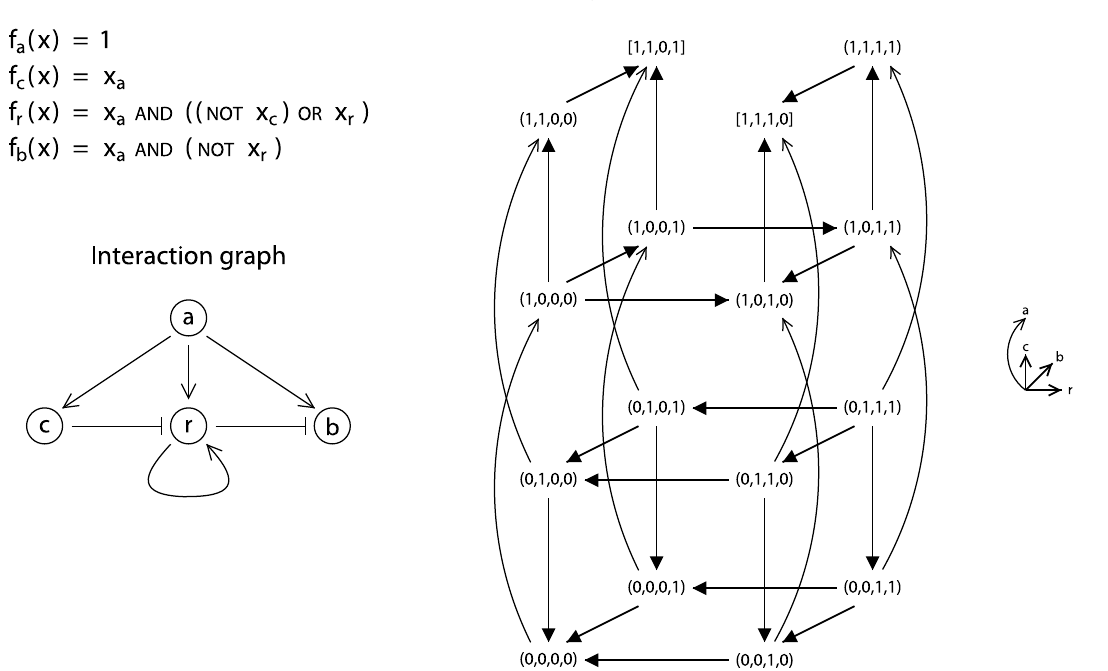
Figure 3. A minimal consistent Boolean network with 4 components. The asynchronous state graph is represented in a 4D-grid, with a in the curved axis (first component), c in the vertical axis (second component), r in the horizontal axis (third component), and b in the last axis (fourth component).